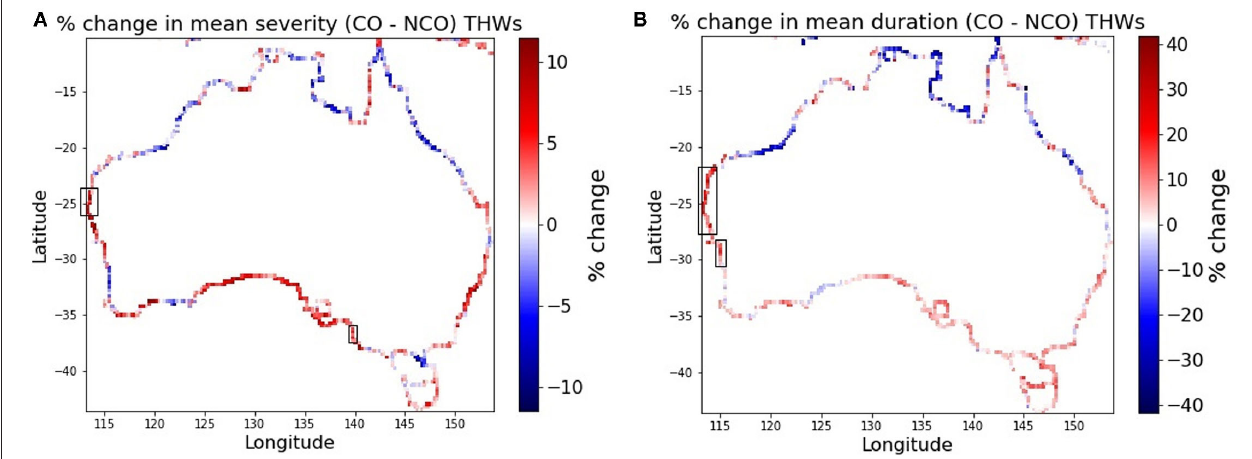
FIGURE 6 | (A) Percentage change in mean severity between co-occurring and stand-alone events (B) Percentage change in mean duration between co-occurring and stand-alone events. Black boxes indicate areas where the changes are significant at a 5% significance level.